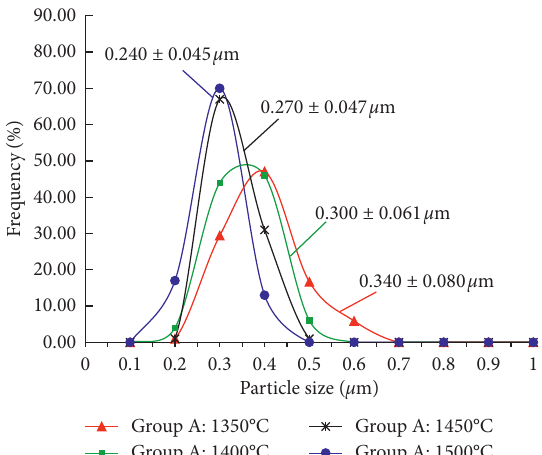
Figure 8: Statistics of particle size distribution of four ceramic rings of group A obtained at different microwave sintering temperatures.